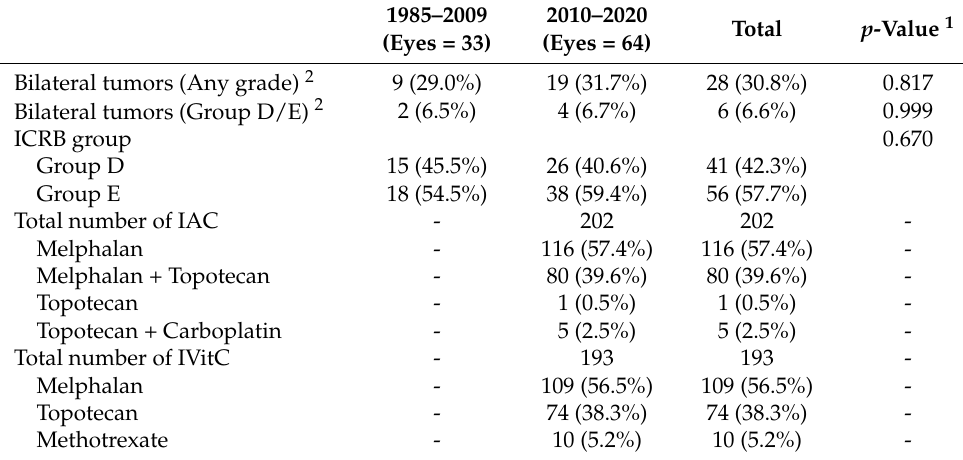
Table 1. Demographics, clinical features, and treatment outcome of 97 eyes of 91 retinoblastoma patients according to time periods in which the diagnosis was